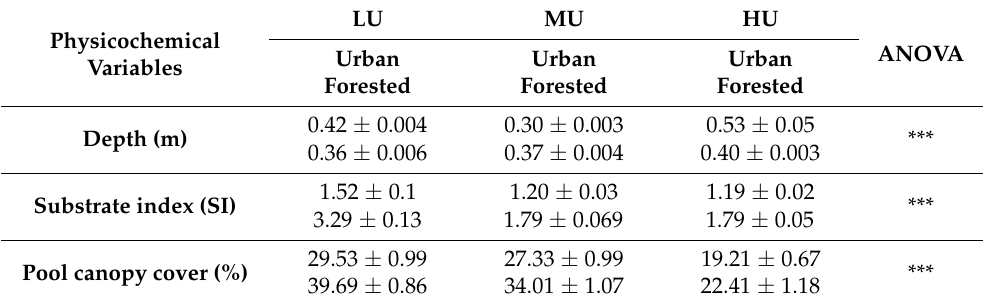
Table 4. The mean ( ± SE) physical measurements in low urban (LU), medium urban (MU), and high urban (HU) reaches in urban (R í o Piedras) and forested (R í o Sabana) watersheds. NS—not significant at p = 0.05; *** p < 0.001. Physicochemical Variables Depth (m) Substrate index (SI) Pool canopy cover (%)